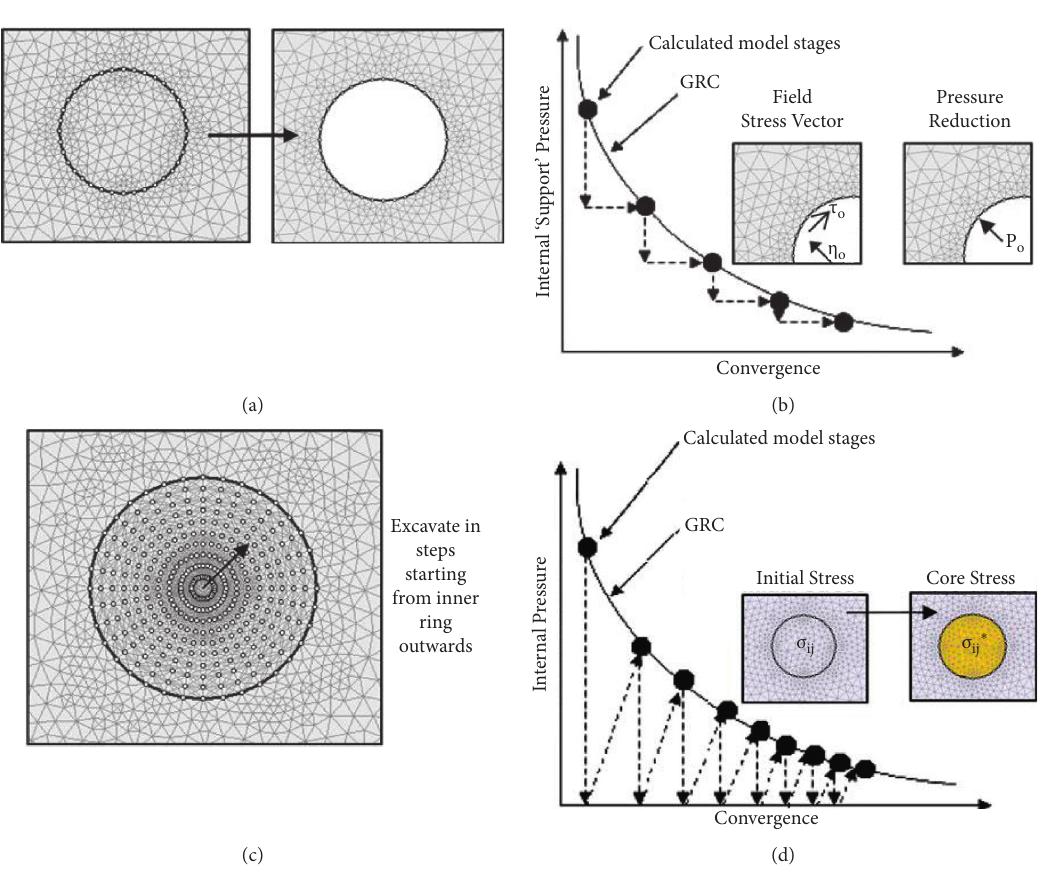
Figure 5: Four strategies used in 2D analysis to approximate the 3D excavation behavior [32].